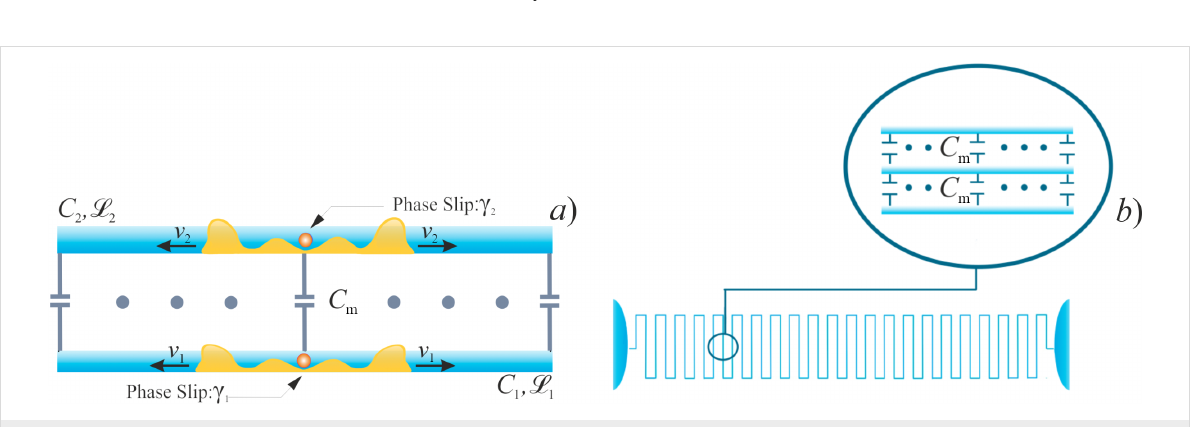
Figure 1: The systems under consideration: a) Two capacitively coupled superconducting nanowires and b) a superconducting nanowire in the form of a meander.